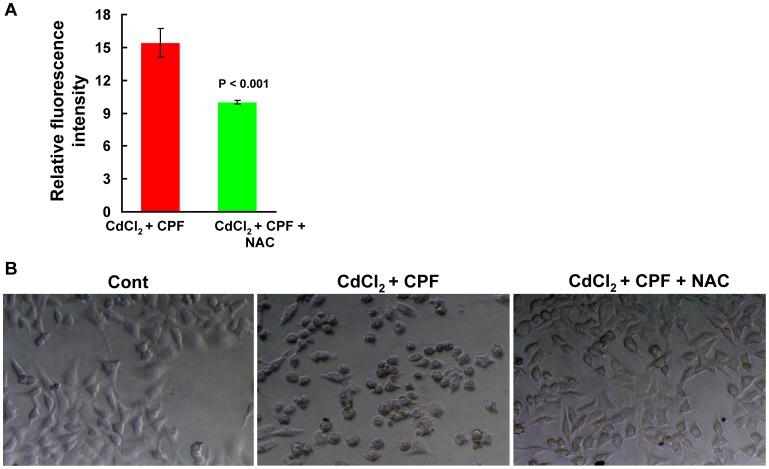
The amelioration of the synergistic hepatoxicity conducted by Cd2+ and CPF by the pre-treatment of NAC.Hep G2 cells were treated individually or jointly with Cd2+ and CPF both at 10 µM for 6 h, and then the intracellular ROS generation (a) was assessed (n = 4). (b) The representative phase-contrast images. The original magnification was 200×.